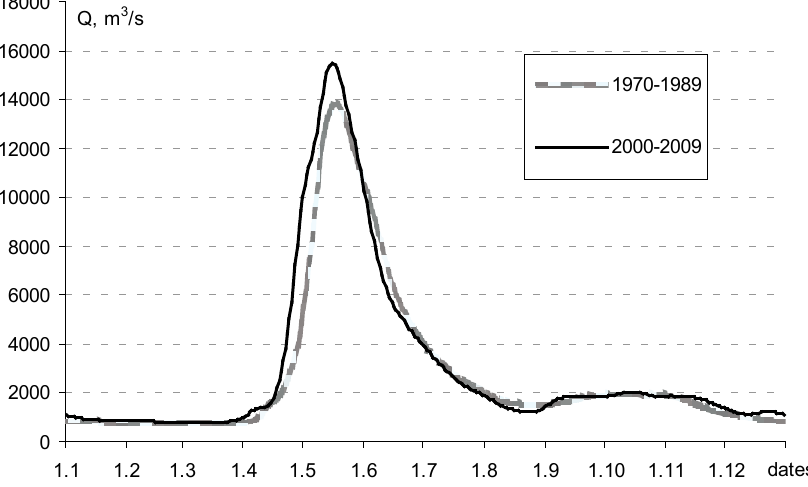
Fig. 2 Simulated mean hydrographs in the Northern Dvina River outlet (gauge Ust-Pinega) for 1970– 1990 and 2000–2009.